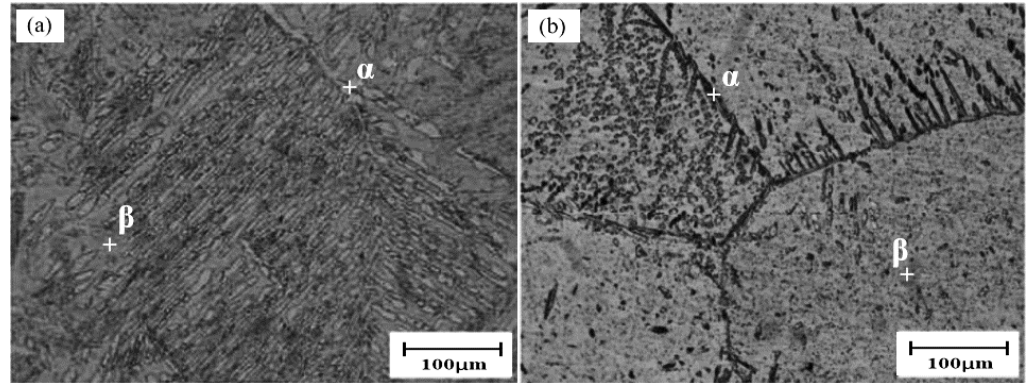
Figure 15. Optical micrographs of ( a ) the 60Cu-Zn-0.6Si and ( b ) the 60Cu-Zn-0.6Si -0.6Sn filler metals [54].